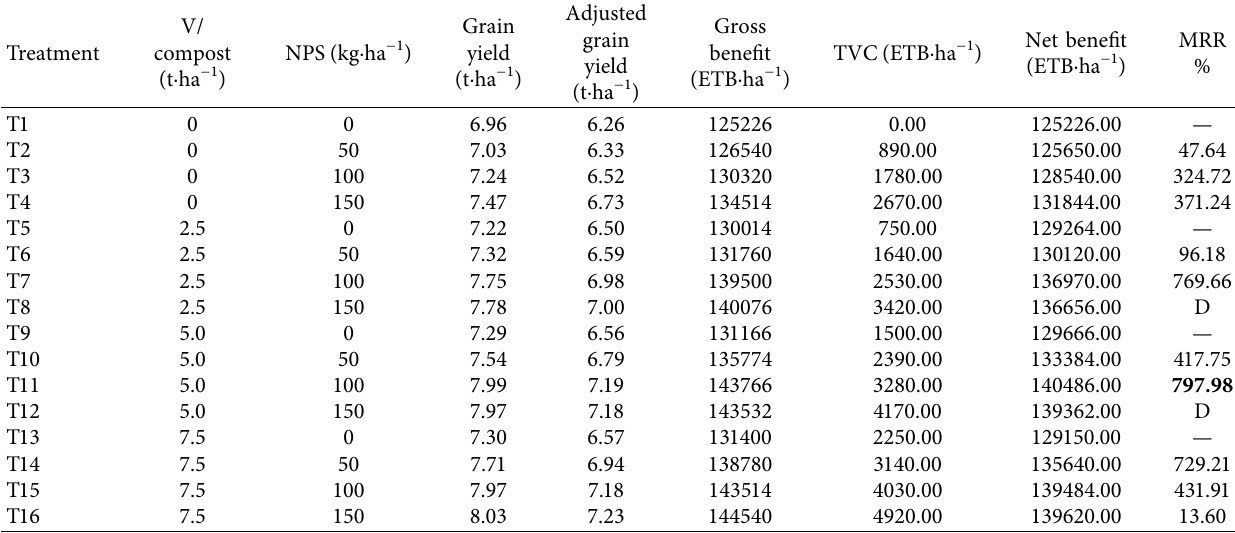
Table 8: Partial budget analysis of maize yield for determination of the economically proftable level of vermicompost and NPSZnB fertilizer